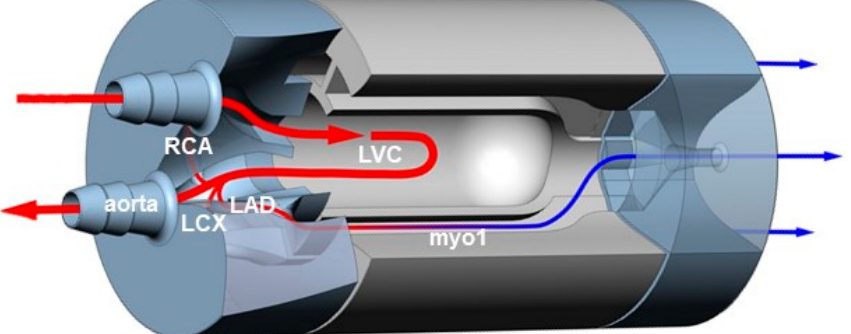
Figure 1. Tailored cross-section of the myocardial perfusion phantom design, consisting of three cylindrical parts fastened together with nylon screws. The middle phantom part comprises the simulated left ventricular cavity (LVC) and three surrounding myocardial regions (myo1-3). The two outer parts contain the in- and outlet connections to the flow circuit and the internal branches from the simulated aorta to myo1 ‒ 3 (only myo1 is visible in this view). The branches correspond to the main coronary arteries, i.e., the left anterior descending coronary artery (LAD), right coronary artery (RCA) and left circumflex coronary artery (LCX). The arrows indicate flow direction and magnitude, and its color differentiates between arterial input (red) and venous output (blue). The closed-loop flow circuit connects to all phantom inlets and outlets (see Figure 2).